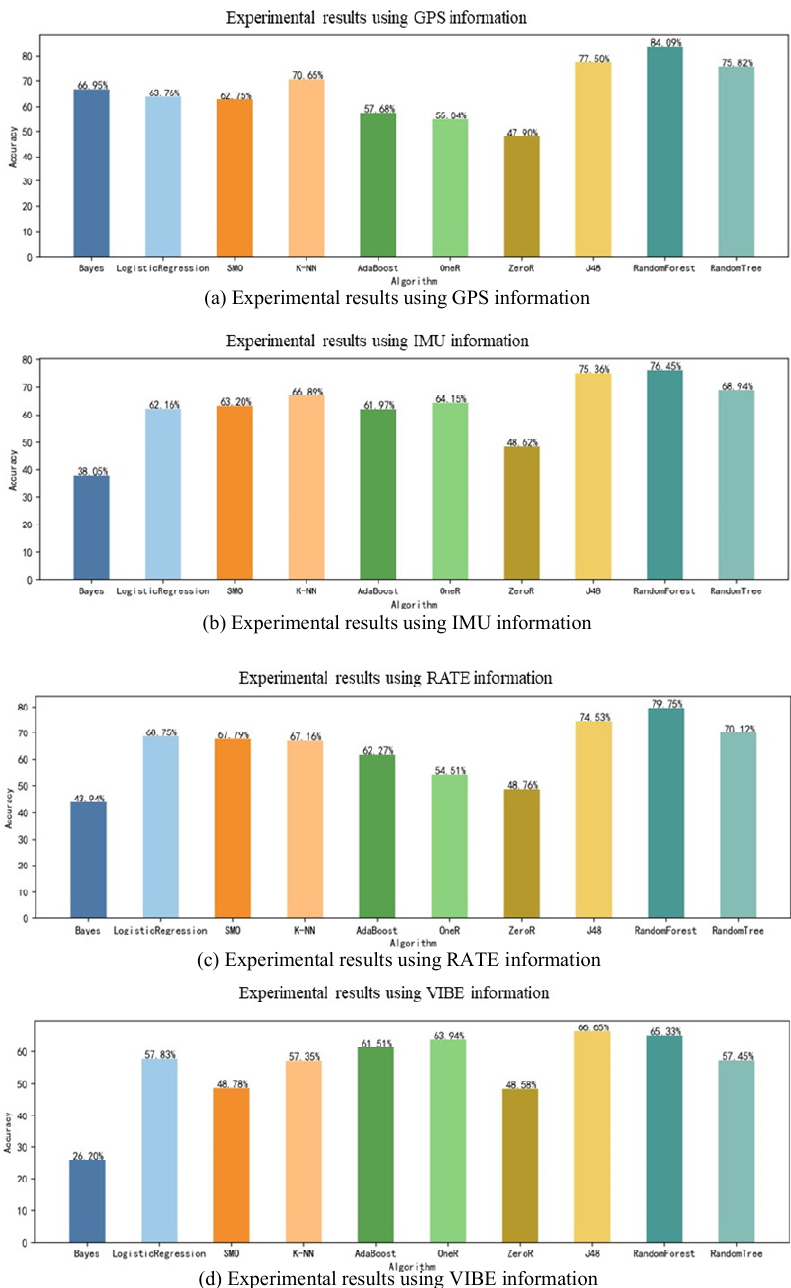
Figure 19. Experimental Results.